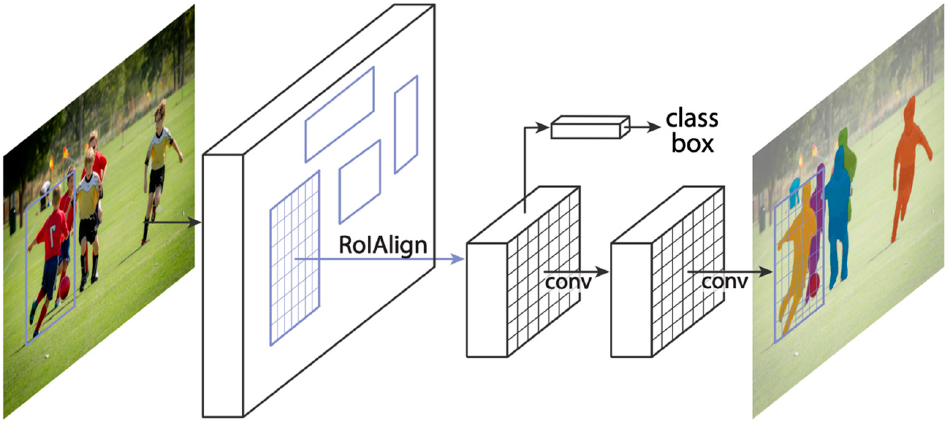
Figure 2. The Mask R-CNN framework for instance segmentation [14].